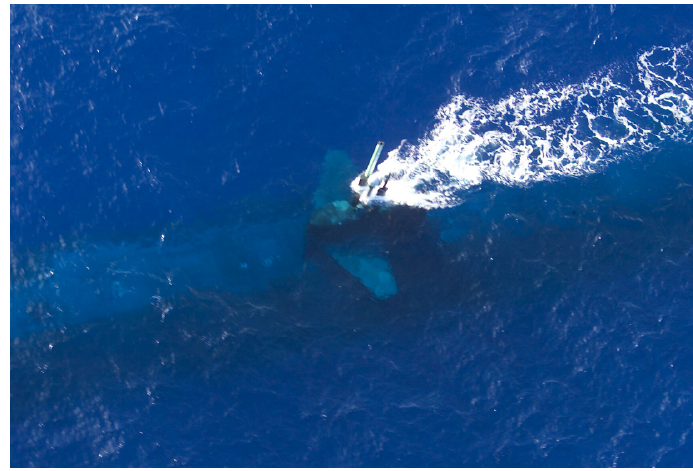
Figure 1. Periscope exposure at periscope depth. Source: